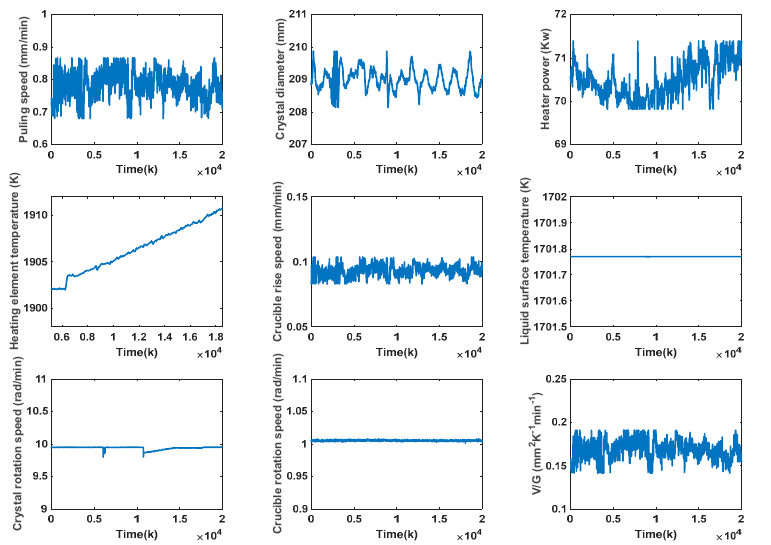
Figure 5. Historical data of each auxiliary variable and V/G values in the actual SSC production process.